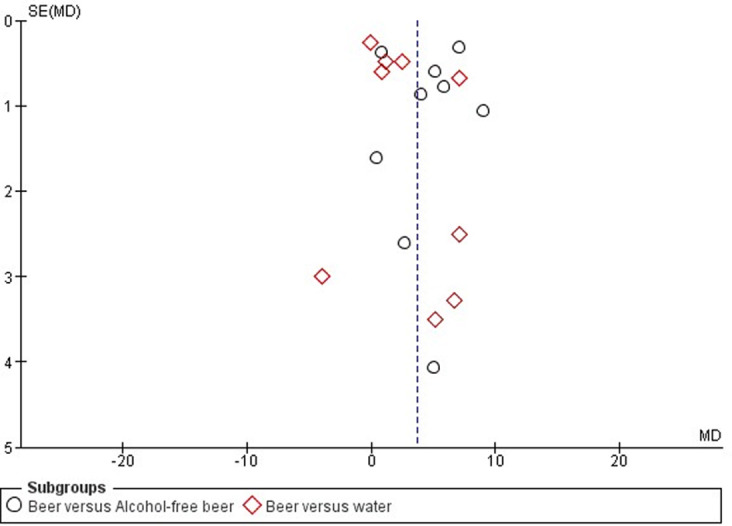
Tunel plot for high density lipoprotein (HDL) cholesterol levels.